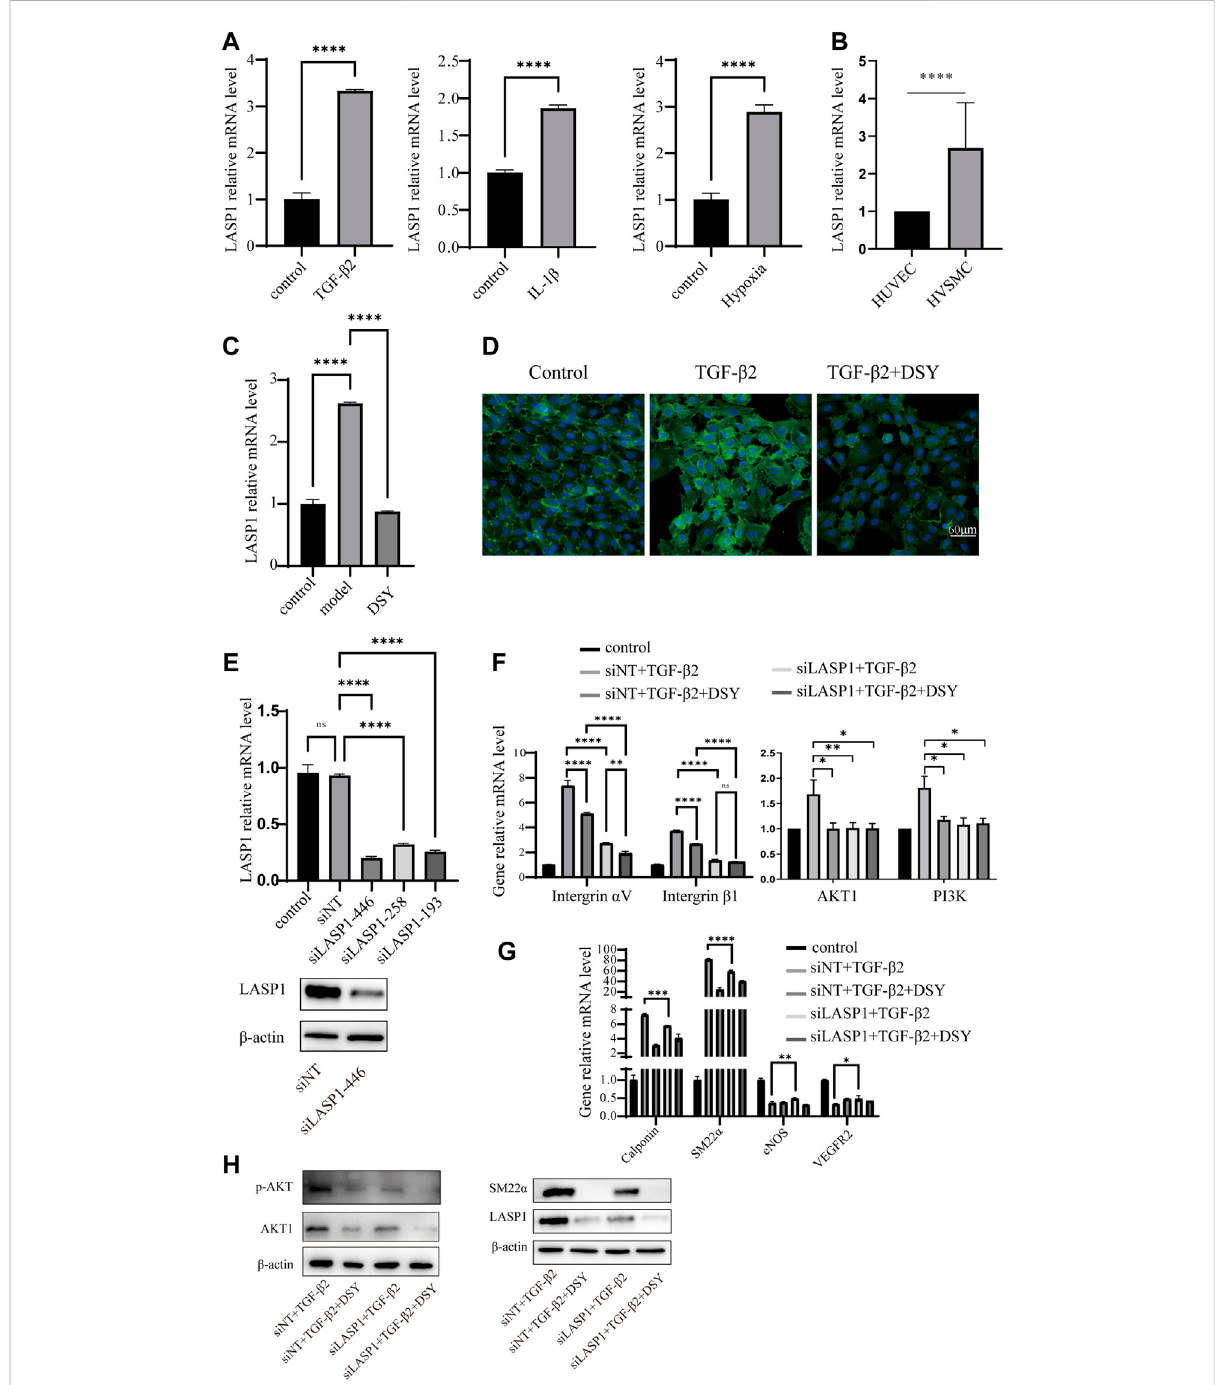
FIGURE 7 LASP1 mediated DSYdown-regulation of integrinexpressioninTGF- β 2-treated cells. (A) HUVECsweretreated with 10 ng/ml IL-1 β , TGF- β 2for 3 days or stimulated with hypoxia for 12 h. RT-qPCR analysis was then performed to detect LASP1 expression. (B) RT-qPCR comparison of LASP1 expression in HUVECs and HVSMCs. (C,D) LASP1 expression in TGF- β 2-pretreated cells supplemented with different doses of DSY measured by (C) RT-qPCR and (D) immuno fl uorescence assay. ( E, upper panel ) RT-qPCR analysis of LASP1 expression after transfection with different siRNAs. ( E, lower panel ) LASP1 expression after transfection with siLASP-446 was checked by western blot. (F) HUVECs were transfected